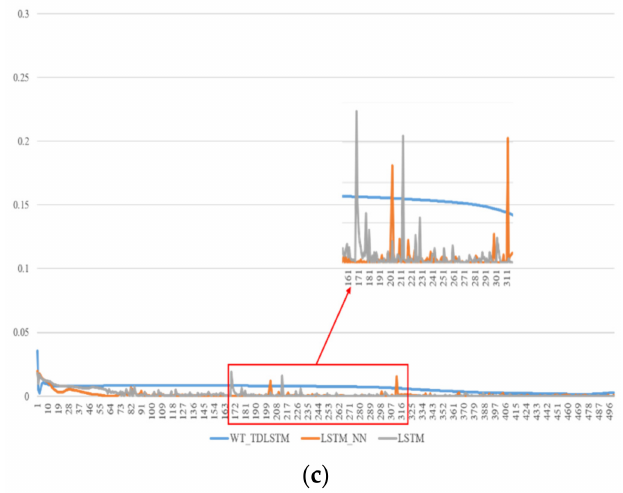
Figure 7. Comparison of convergence curves of the different models: ( a ) the change of the convergence curve for LSTM, LSTM-NN, and WT_TDLSTM models on residential monthly electricity price dataset; ( b ) the change of the convergence curve for LSTM, LSTM-NN, and WT_TDLSTM models on commercial monthly electricity price dataset; ( c ) the change of the convergence curve for LSTM, LSTM-NN, and WT_TDLSTM models on industrial monthly electricity price